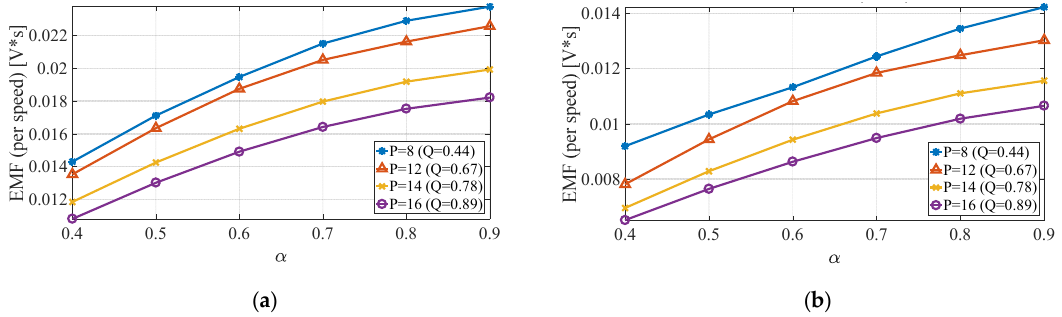
Figure 9. Line to line ( a ) and phase ( b ) back-emf RMS values of different pole spans α Both the line and phase back-emf magnitude slopes tend to decrease along with rising pole span,